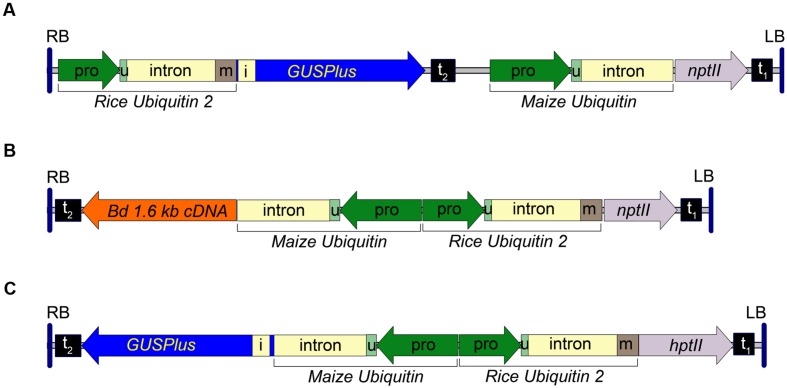
Transfer DNA (T-DNA) region of the pARS1-RUBQ2-GUSPlus, pARS2-ZmUbi1-1.6 kb and pARS3m-ZmUbi1-GUSPlus binary vectors.
(A) The pARS1-RUBQ2-GUSPlus 8004 bp T-DNA with the synthetic GUSPlus reporter gene (Broothaerts et al., 2005) under control of the Rice Ubiquitin2 (RUBQ2) promoter (pro) – intron – monomer (m) (Wang et al., 2000) and terminated with the nopaline synthase (nos) terminator (t2) is shown. The coding sequence for the RUBQ2 ubiquitin monomer (m) is translationally fused to GUSPlus. The neomycin phosphotransferase II (nptII) paromomycin resistance marker gene is under control of the Maize Ubiquitin 1 (ZmUbi1) promoter and intron (Christensen and Quail, 1996) with polyadenylation directed by the Cauliflower Mosaic Virus (CaMV) 35S terminator (t1). (B) The pARS2-ZmUbi1-1.6 kb 8200 bp T-DNA with a B. distachyon cDNA under control of the ZmUbi1 promoter and intron and terminated with the nos terminator (t2) is shown. The RUBQ2 ubiquitin monomer (m) is translationally fused to the nptII paromomycin resistance marker gene and terminated by the CaMV 35S terminator (t1). (C) pARS3m-ZmUbi1-GUSPlus vector contains a 7757 bp T-DNA of with the GUSPlus gene under control of the ZmUbi1 promoter and intron and the nos terminator (t2). The RUBQ2 promoter – intron – monomer is translationally fused to the hygromycin phosphotransferase II (hptII) resistance gene and terminated with the CaMV 35S terminator (t1). The 5′ UTR (u) of each promoter is indicated. Each T-DNA is delineated by the right (RB) and left (LB) borders from the Ti plasmid of A. tumefaciens strain C58. Intron 1 (i) of the Ricinus communis Catalase 1 gene (Suzuki et al., 1994) in GUSPlus ensures that any plant tissue that exhibits β-glucuronidase activity is due to eukaryotic (spliced) expression of GUSPlus.